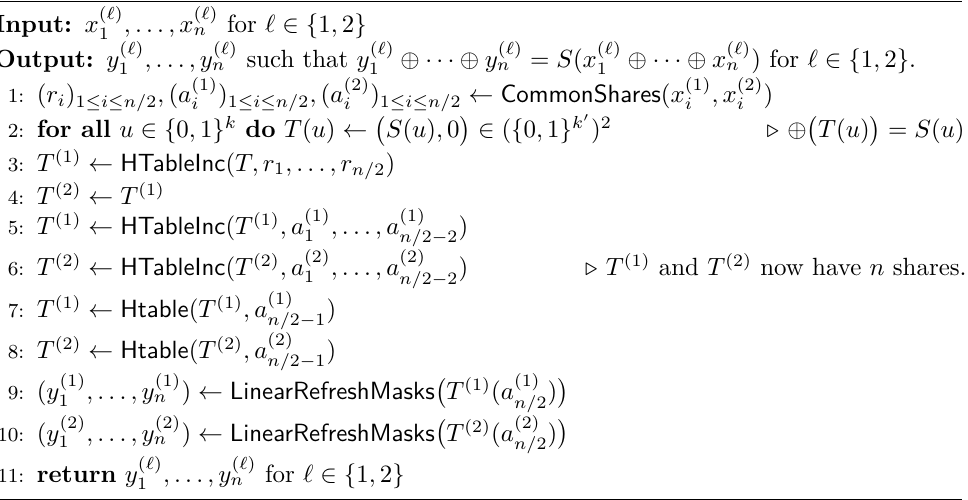
Algorithm 11 Common Table Inc : evaluation of of y (1) = S ( x (1) ) and y (2) = S ( x (2)